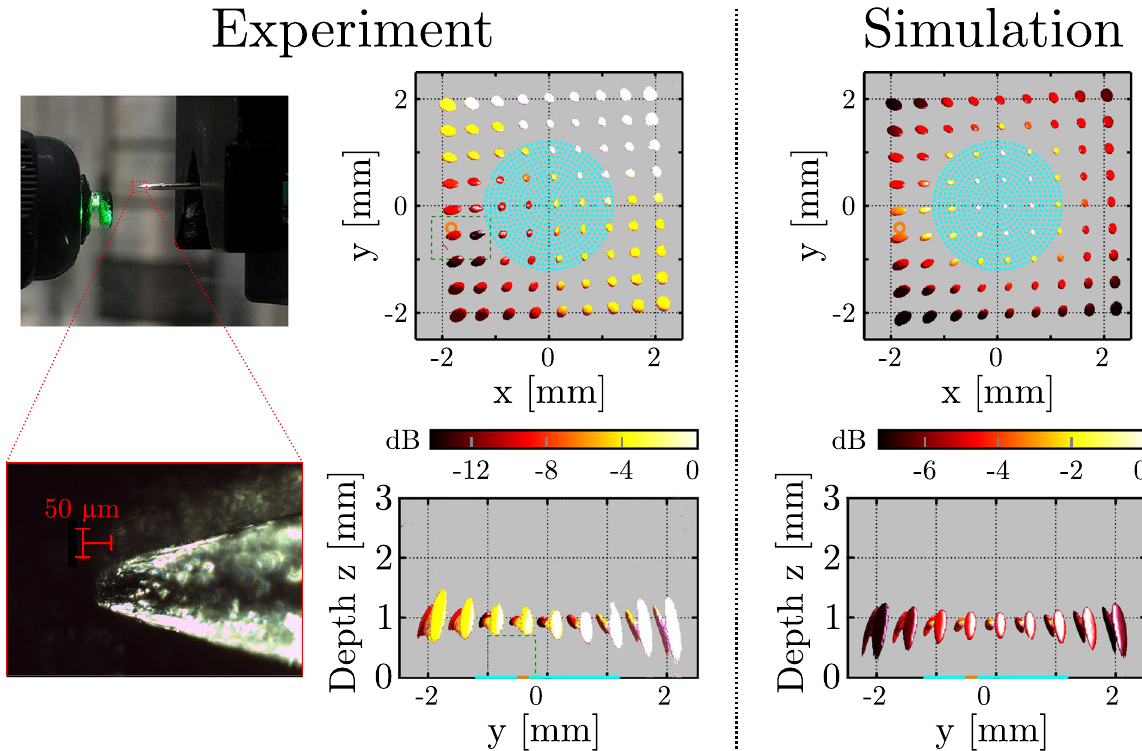
Figure 4. Measurement and simulation of the spatial variation of the point spread function. In the experiments, a single pushpin tip was positioned in 9 × 9 positions spaced 0.5 mm apart, and at each position a three- dimensional (3D) image of the pushpin tip was obtained. The illumination pattern (indicated in light blue) comprised 573 source locations distributed along fourteen equidistant concentric circles. The receiver position is indicated in orange. Left column: Macro- and microscopic photographs of the pushpin. Middle column: Compound image displaying the full-width-at-half-maximum (FWHM) isosurfaces of all 81 3D images; each of these isosurfaces corresponds to the local point spread function of the imaging system. The colour map indicates the maximum image intensity (normalised to 0 dB) for each of the 81 separate experiments. The blind spot indicated by the green dashed box is not reconstructed to avoid image artefacts due to overlap between signal and acoustical cross-talk. Right column: Compound image displaying the local point spread function obtained from 81 separate imaging simulations for an infinitesimally small point